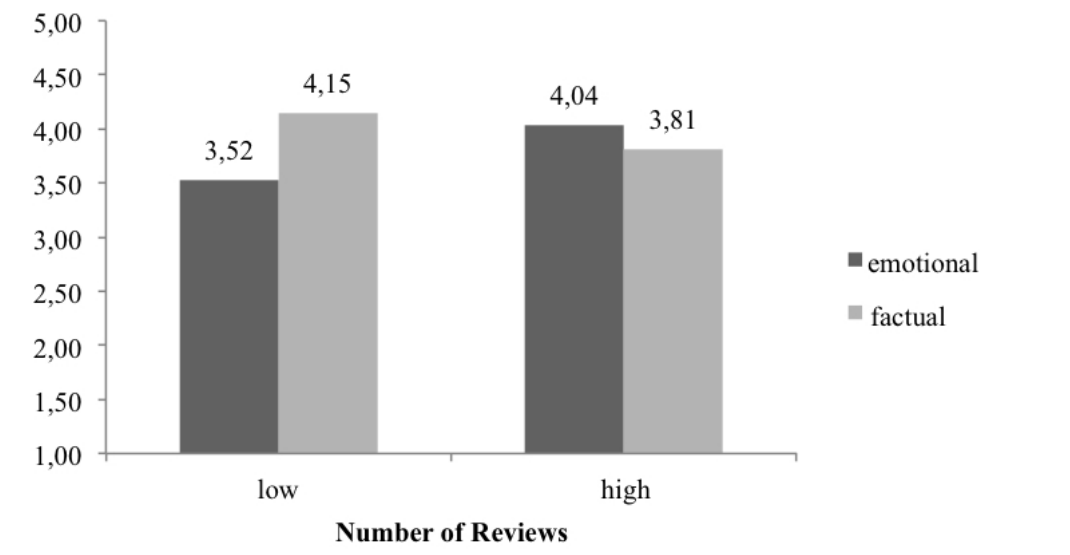
Figure 6. Credibility of the review as a function of review style and number of